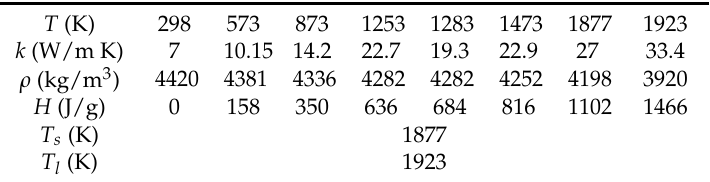
Table 1. Summary of material thermo-physical properties of Ti6Al4V